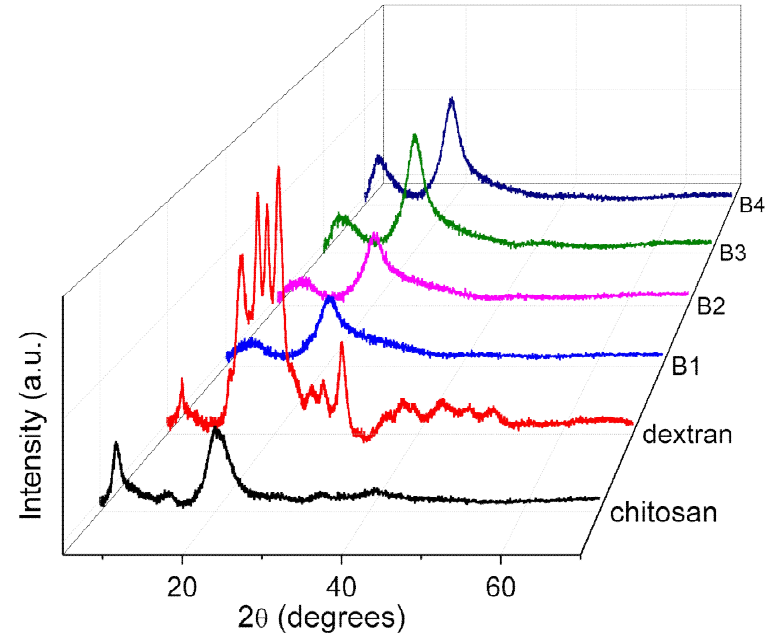
Figure 1. XRD patterns for chitosan, dextran, and nanocomposites (B1, B2, B3, and B4). In the pattern of chitosan, two crystalline peaks were observed at 2 θ = 7.3 ◦ and 13.9 ◦ , while one amorphous peak appeared at 2 θ = 20.5 ◦ and 40.9 ◦ . Dextran bore crystalline peaks at 2 θ = 7.0 ◦ , 15.5 ◦ , 17.7 ◦ , 19.0 ◦ , 20.5 ◦ , 22.2 ◦ , 25.7 ◦ , 26.8 ◦ , 29.4 ◦ , 35.3 ◦ , 38.3 ◦ , 43.6 ◦ , and